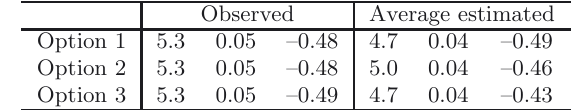
Table 1. Observed and average of the estimated { var(ˆ β 0 ), cov(ˆ β ,ˆ β var(ˆ β 1 ), and 0 1 ) } for each of three options. Entries are repeatable to ± 1% relative or